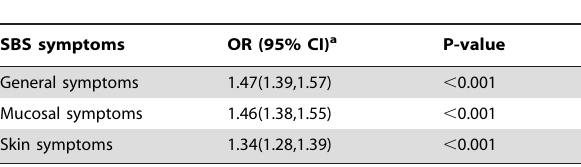
Table 6. Association between SBS symptoms (weekly or sometimes) and Continuous OH-score (as a continuous variable, range from 0–7) (n =4530).